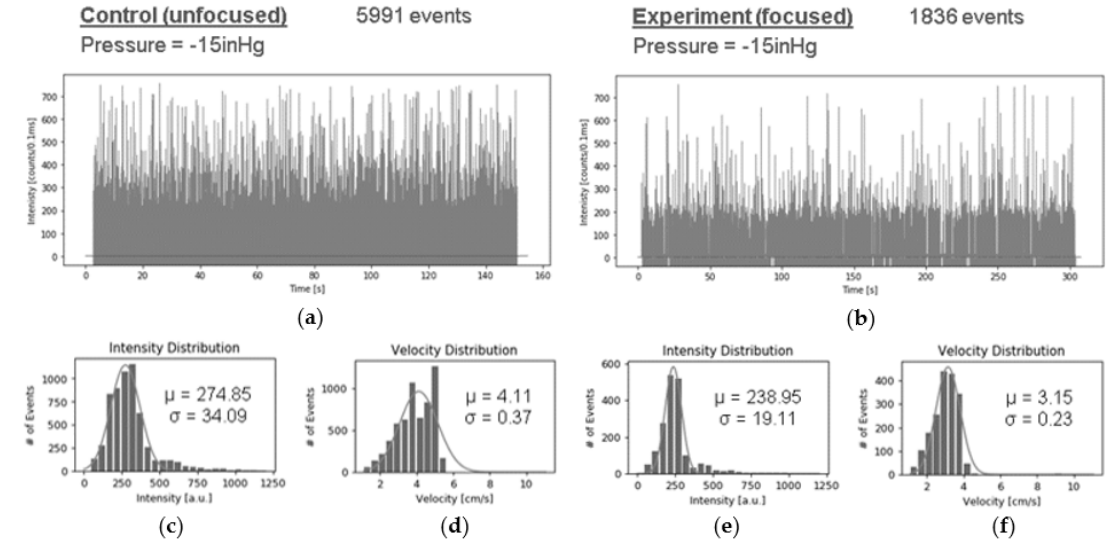
Figure 10. Signal intensity traces in counts per 0.1 ms were collected for ( a ) unfocused operation over 150 s and ( b ) focused operation over 300 s. ( c – f ) Histogram distributions for signal intensity and fluid velocity show more consistent signal with three-dimensional hydrodynamic focusing (3DHDF).